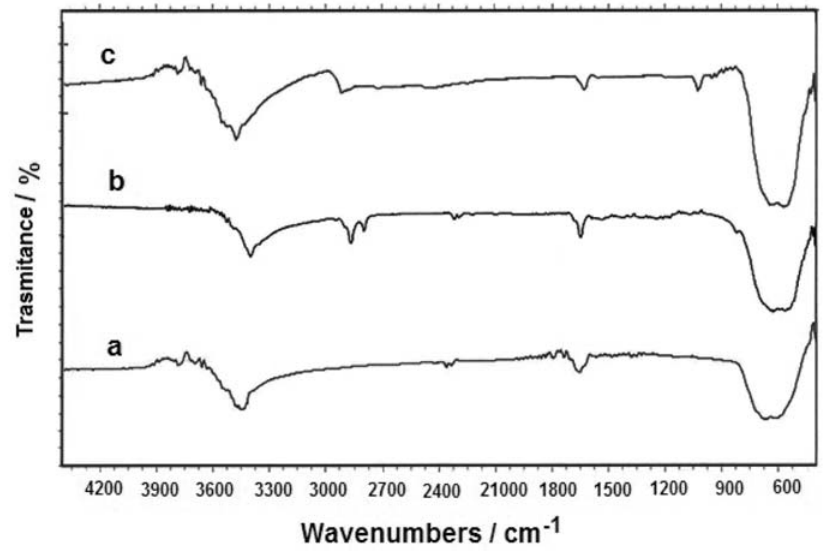
Fig. 2: FT-IR spectra of: (a) bare Al